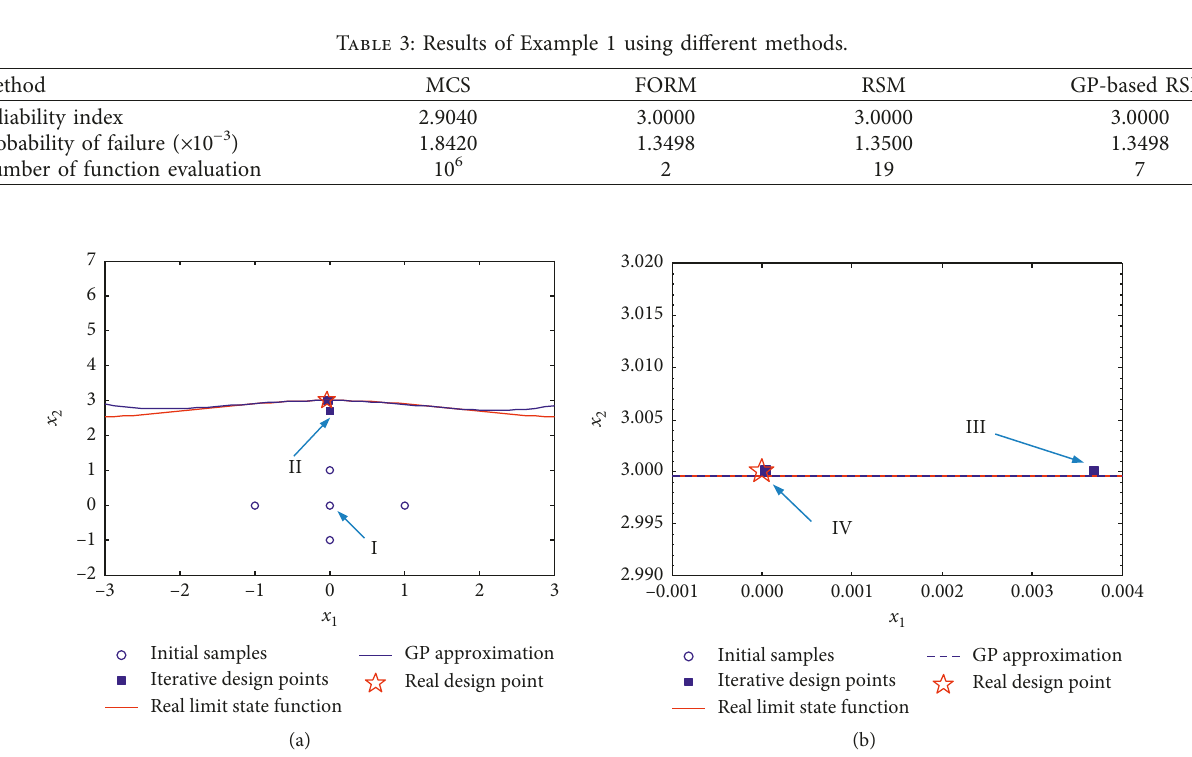
Figure 2: Compare the curve of limit state function from GP based on the final training samples with that from the real limit state function, where the boxes refer to the design points at iterative step in GP-based RSM: (b) enlarged figure; (a) in the range